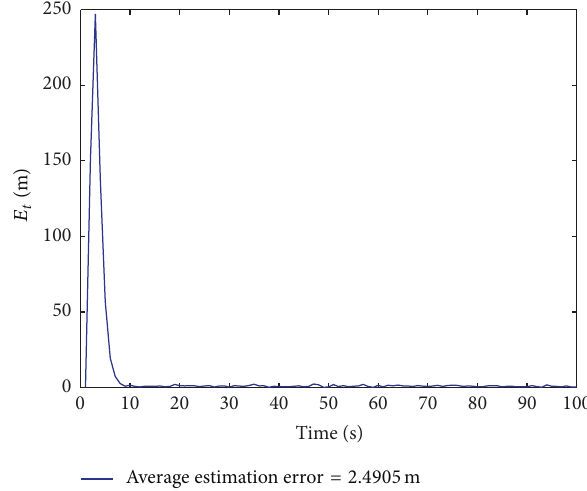
Figure 11: Estimation error for circular target trajectory without beam pointing